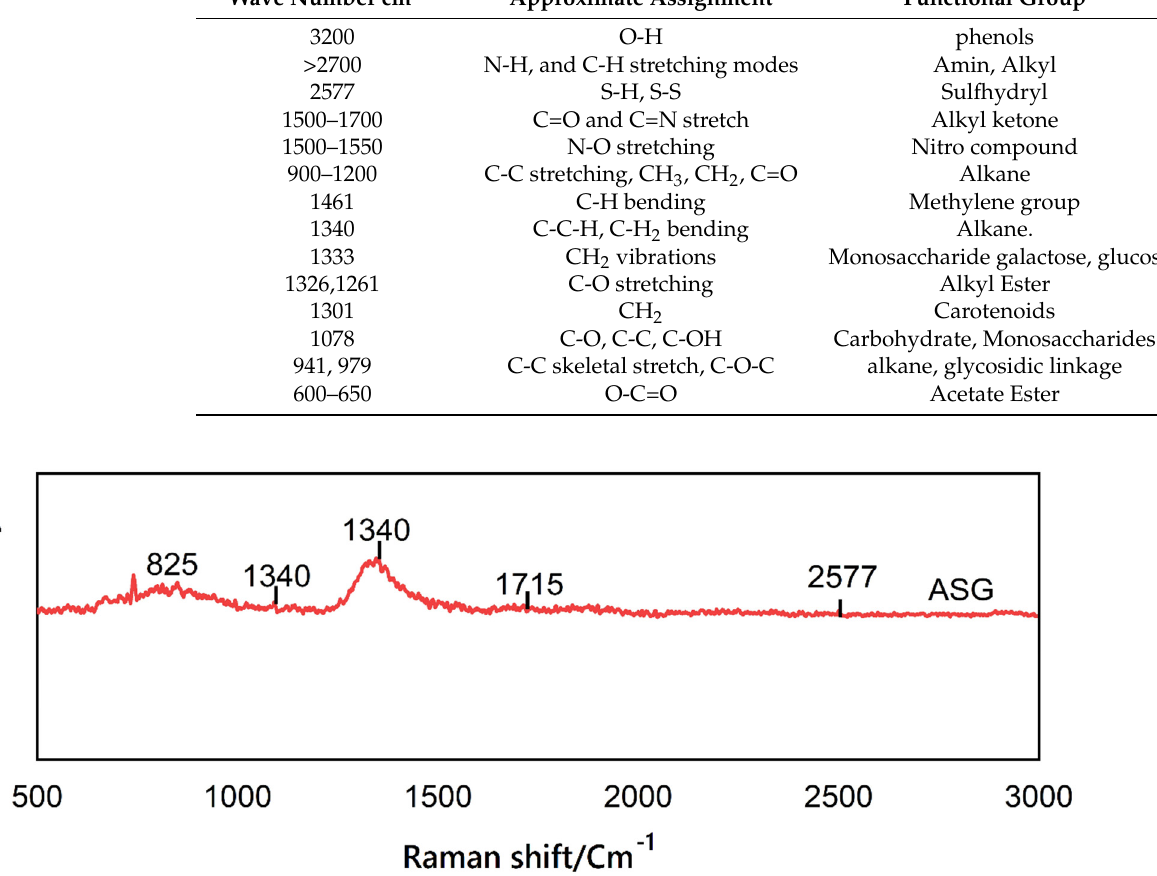
Figure 2. Typical Raman spectrum of Acacia Seyal gum powder sample.